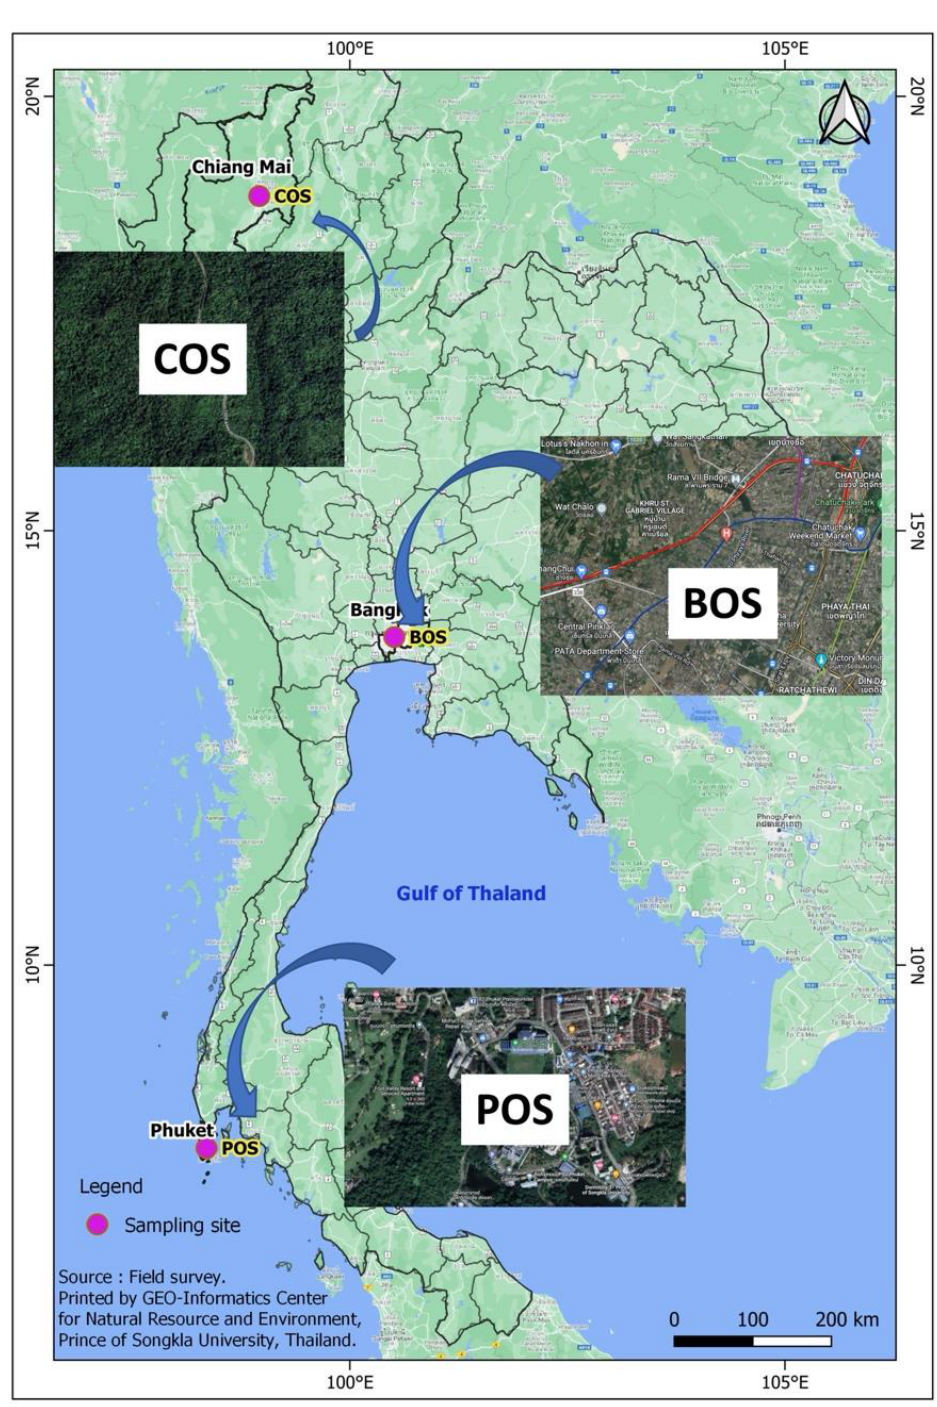
Figure 1. Air quality observatory sites at Chiang-Mai (COS), Bangkok (BOS), and Phuket